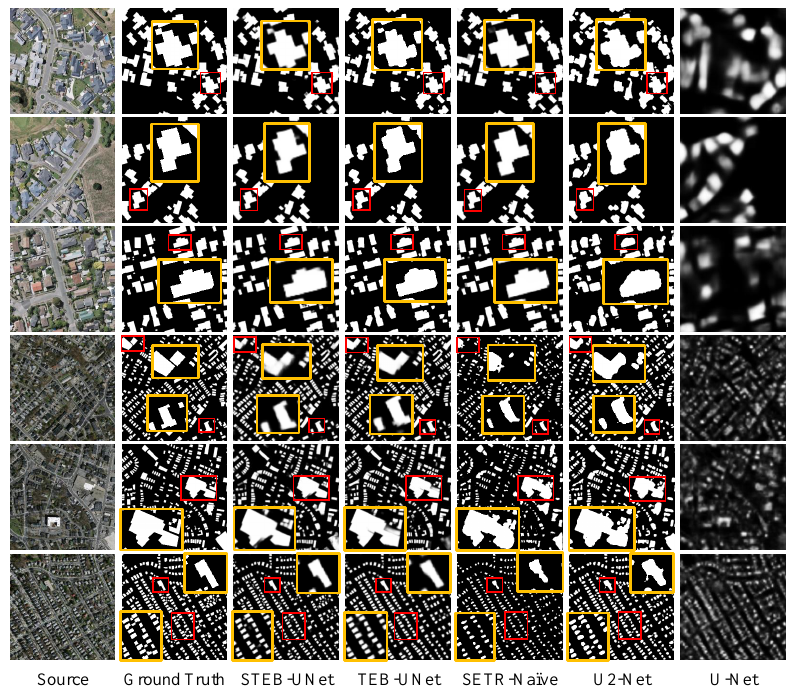
Figure 5. The comparison of the building extraction results of different networks on the WHU (first to third line) and Massachusetts (fourth to sixth line) dataset. The building areas are drawn white. The areas where the STEB-UNet shows greater advantages are in red boxes, whose zoom-in figures are shown in their near yellow